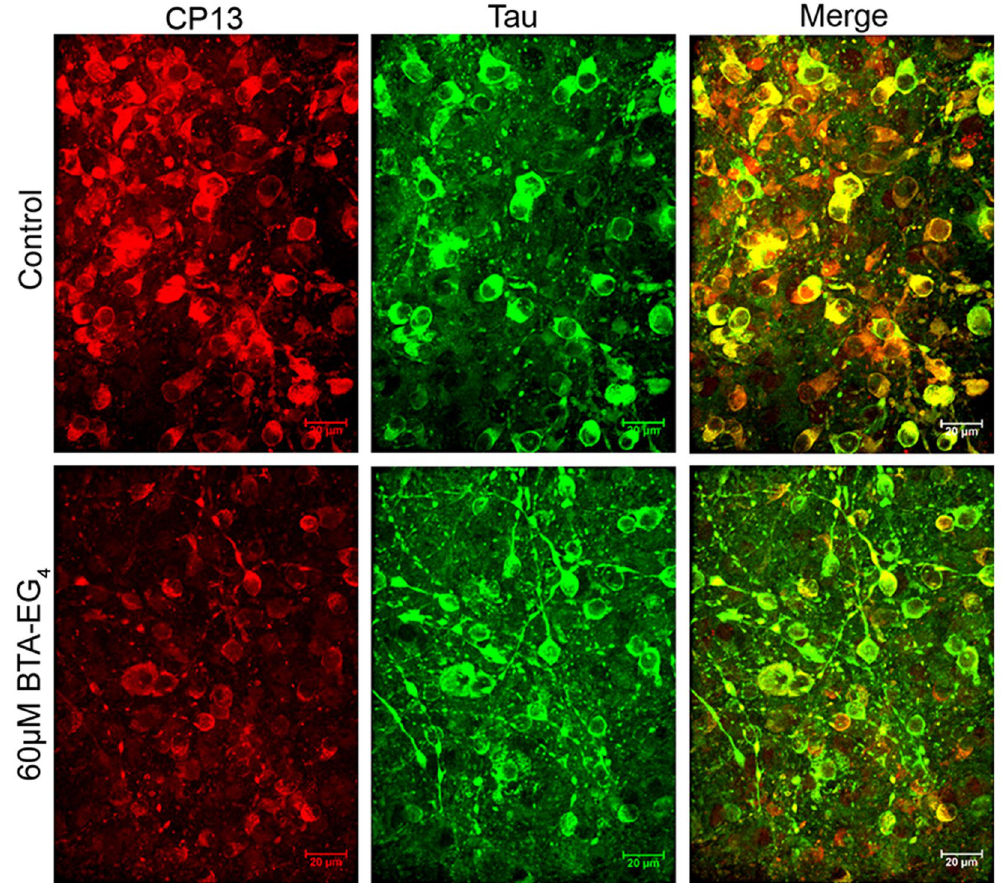
Figure 4. BTA-EG 4 reduces tau phosphorylation and increases axonal tau distribution in 3xTg-AD brain slice cultures. Representative images from fixed 3xTg-AD organotypic brain slice cultures cultured for 28 DIV and treated with control (DMSO, 0 μ M) or 60 μ M BTA-EG4 for 48 h, immunolabelled with antibodies against total tau (both non-phosphorylated and phosphorylated; DAKO) - green and CP13 (phospho-Ser202) - red. Scale bar is 20 μ